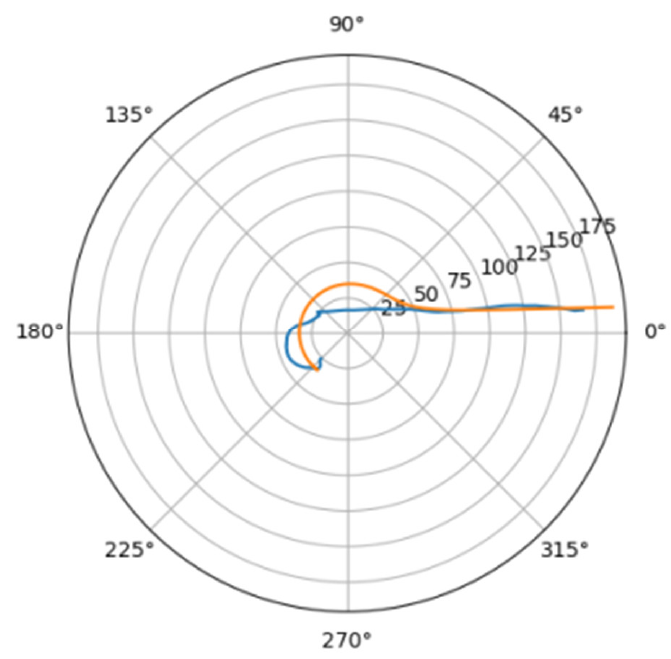
Figure 16. Approximations for zag_a.